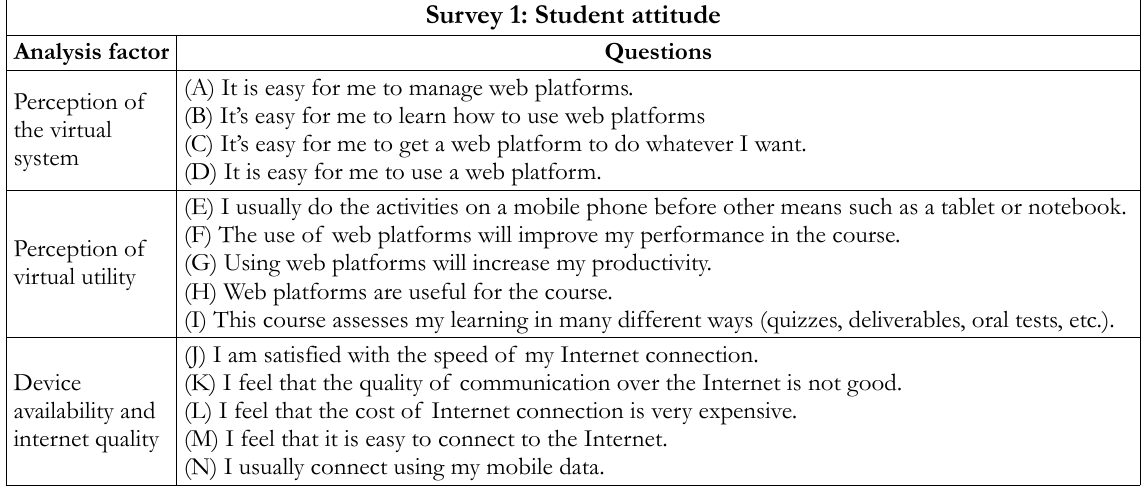
Table 2. Dimensions analyzed in survey 1 (Zambrano, 2016)